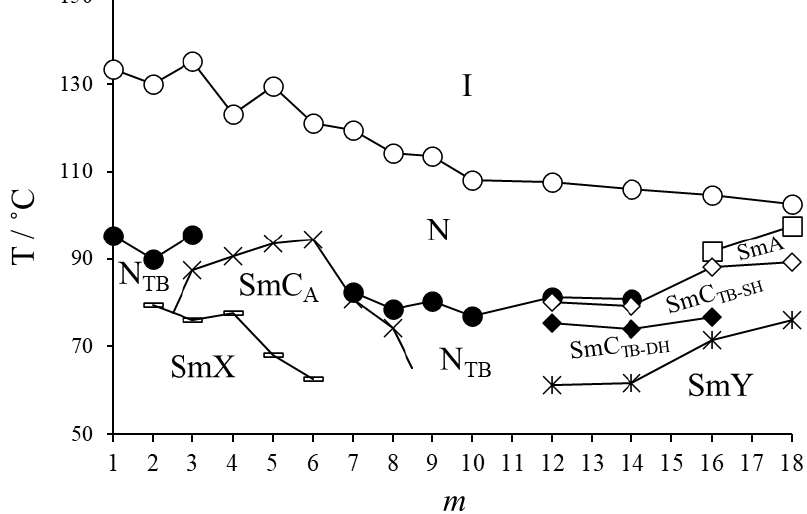
Figure 23. The dependence of the transition temperatures on the length of the terminal chain, m , for the CB10O. m series [104]. The melting points have been omitted for the sake of clarity. Unfilled circles denoted T NI ; filled circles T NTBN ; crosses T SmCN/NTB ; dashes T SmX- ; squares T SmAN ; unfilled diamonds T SmCTB-SH- ; filled diamonds T SmCTB-DHSmCTB-SH ; stars T SmY- .